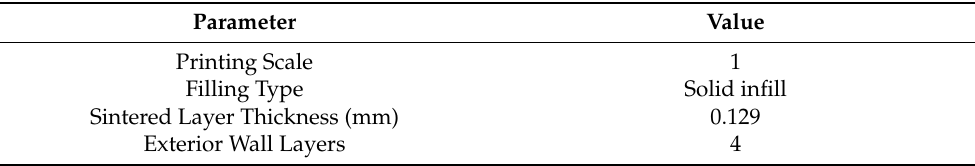
Table 1. Printing parameters for the additive manufacturing of copper parts by